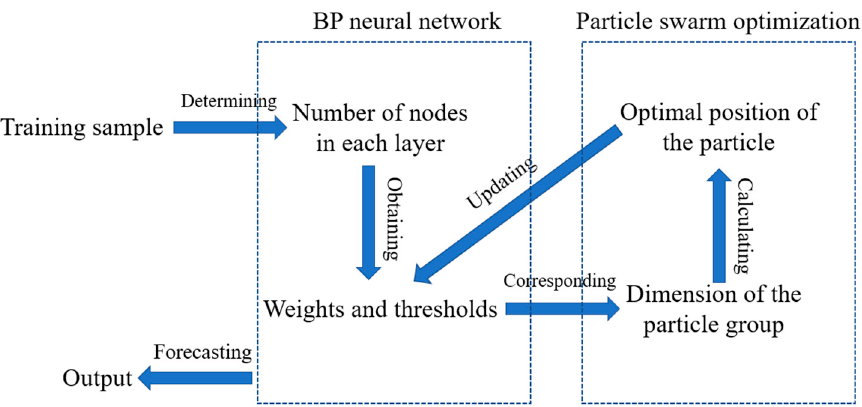
Figure 2. Principle of the PSO-BP integrated model.